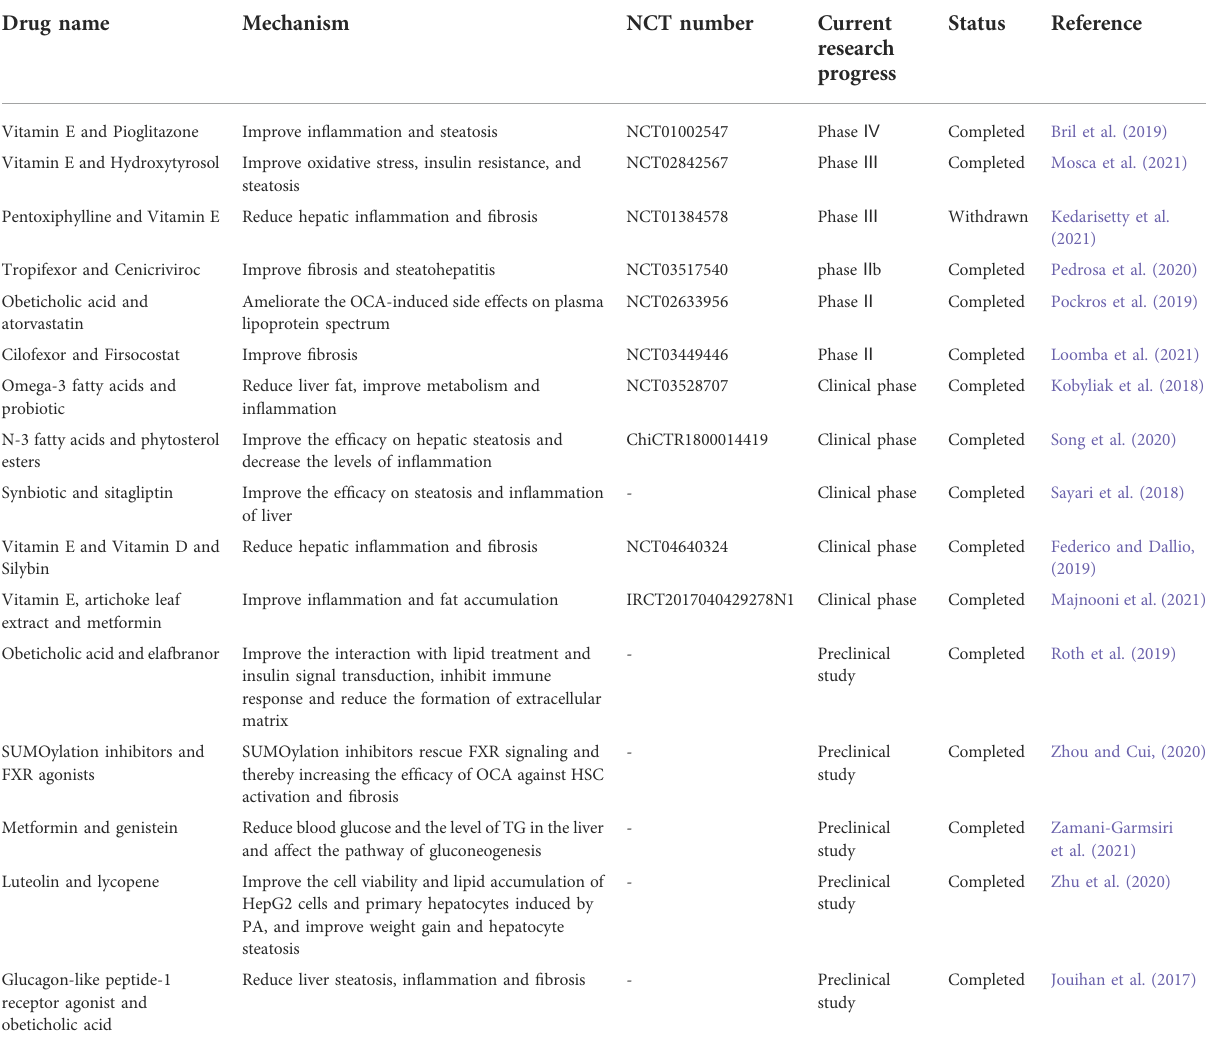
TABLE 5 Mechanism and research progress of combination therapy for